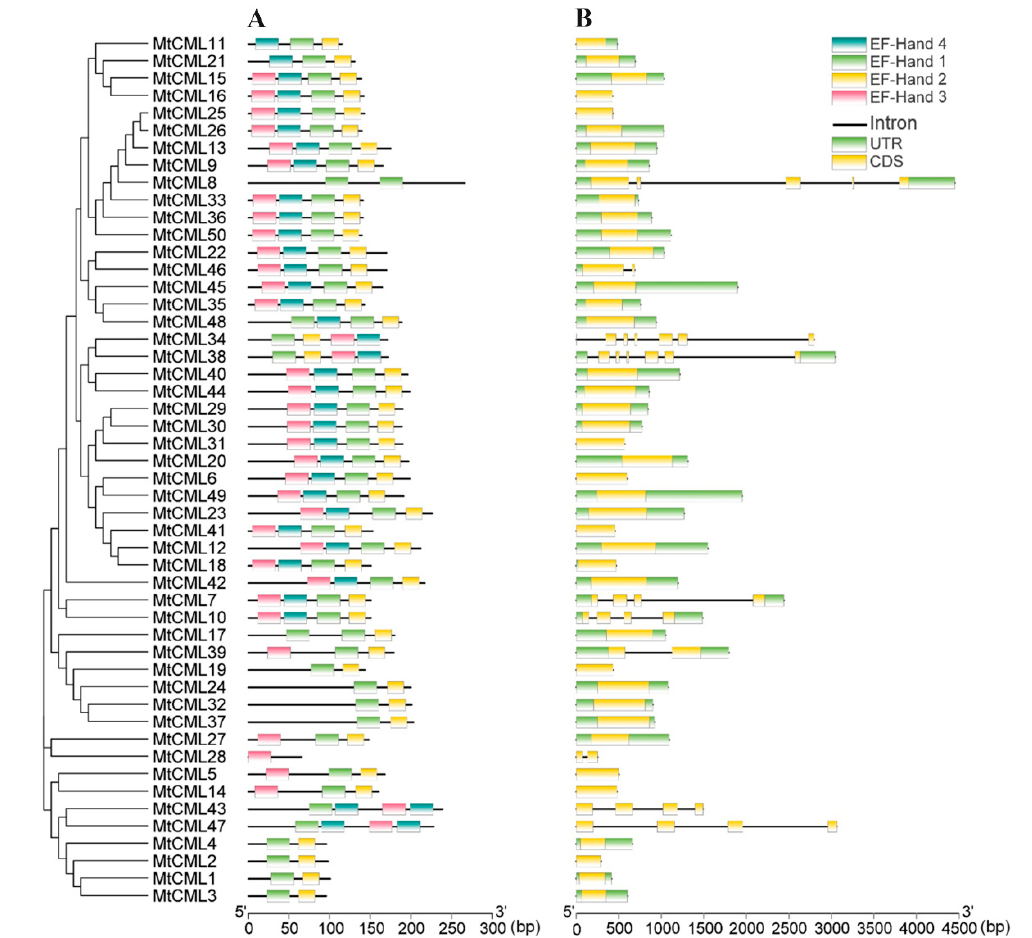
Figure 2. Characterization of MtCML genes and MtCML proteins . ( A ) EF-hand motifs; ( B ) exon–intron structure distribution.